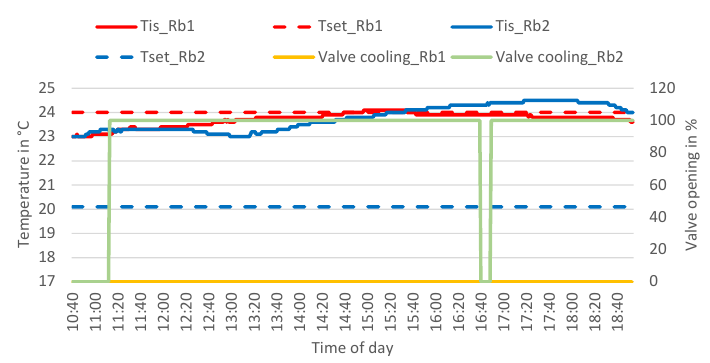
Figure 11. Room and set temperatures, and valve openings for two benchmark rooms in the field